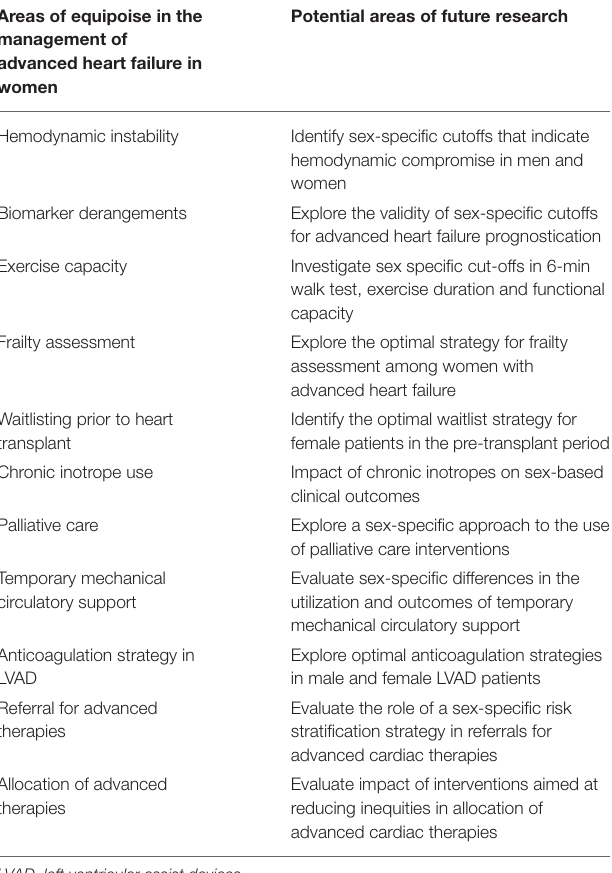
TABLE 2 | Future areas of study in the management of advanced heart failure in women. Areas of equipoise in the management of advanced heart failure in